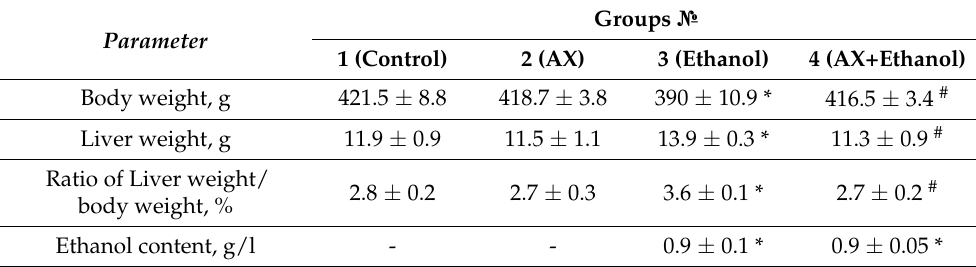
Table 1. Changes in characteristics after the ethanol treatment of rats. The data are presented as the means ± SD of three independent experiments. * p < 0.05 significant difference in the values in comparison with the control (group 1). # p < 0.05 compared to RLM isolated from ethanol- administrated rats (group 3). The statistical significance of the differences between the pairs of mean values was evaluated using the Student–Newman–Keul